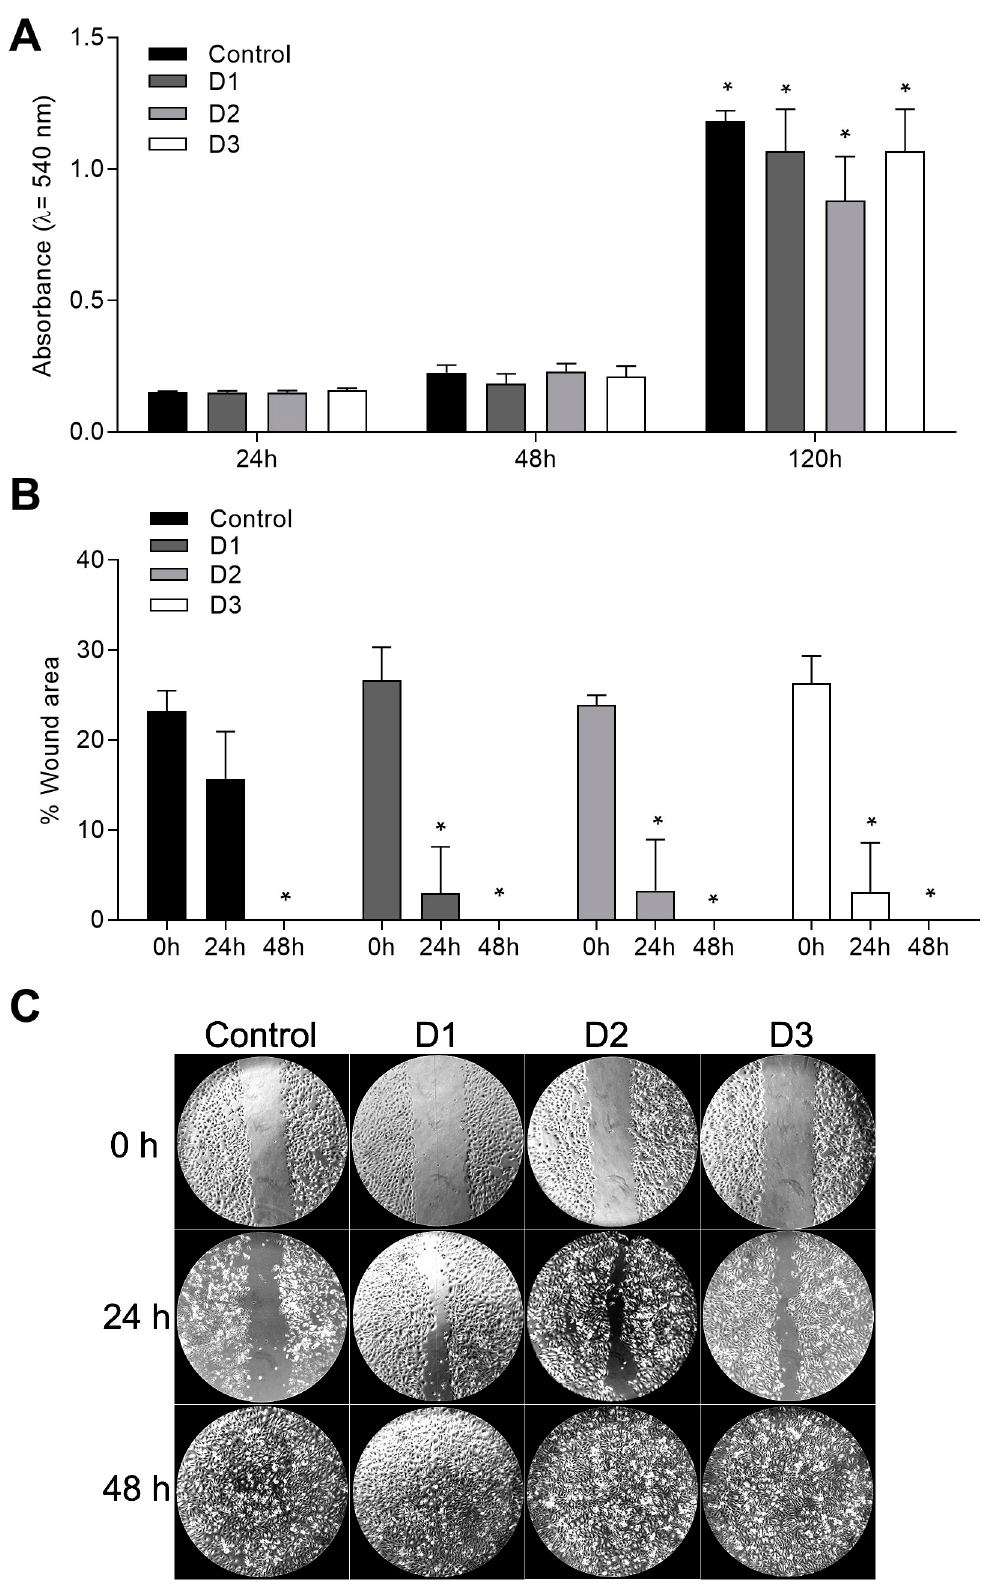
Figure 2- For the in vitro experiment, four photoactivated increments were immersed in a cell culture medium with three different volumes and dilutions: 5.5 mL (Dilution 1 – D1), 11.0 mL (Dilution 2 – D2), and 22.0 mL (Dilution 3 – D3). A group of cells grown under ideal conditions treated exclusively with the basal medium was used as a control group. A – Viability assay using Human keratinocytes (HaCaT) plated in quadruplicate for the MTT assay (3-(4,5-dimethylthiazol-2yl)-2,5-diphenyl tetrazolium bromide) for 24, 48, and 120 hours (h). B – Cell scratch migration test with HaCaT cells plated and evaluated at 0, 24, and 48 hours (h). C – Representative image of the cell migration analysis. Kruskal–Wallis nonparametric test followed by Dunn’s multiple tests. Only p<0.05 was considered statistically significant. A: The * means different results from four hours groups within the same treatment. B: The * means different results from 0-hour groups within the same